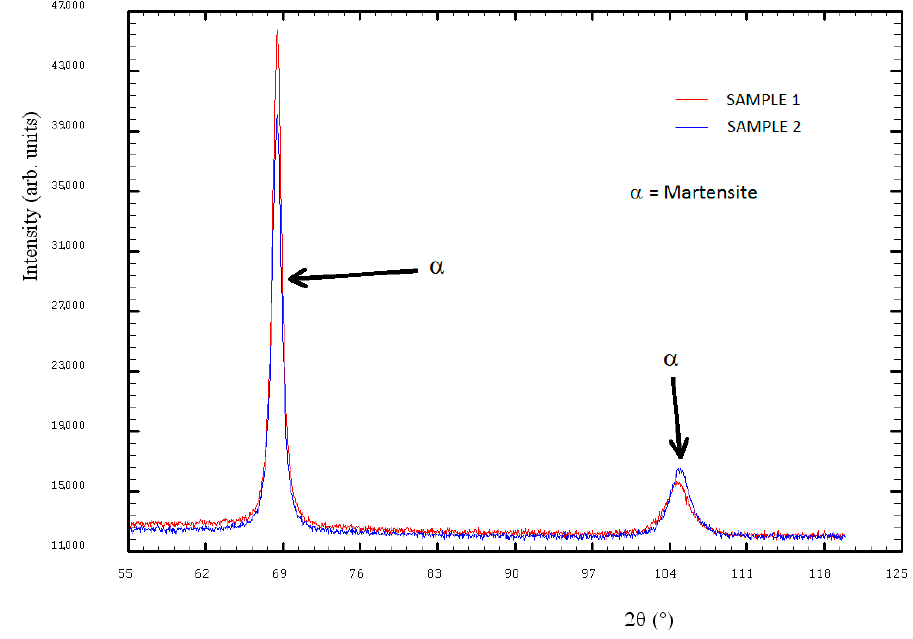
Figure 5. X-ray diffractograms of Sample 1 and Sample 2.